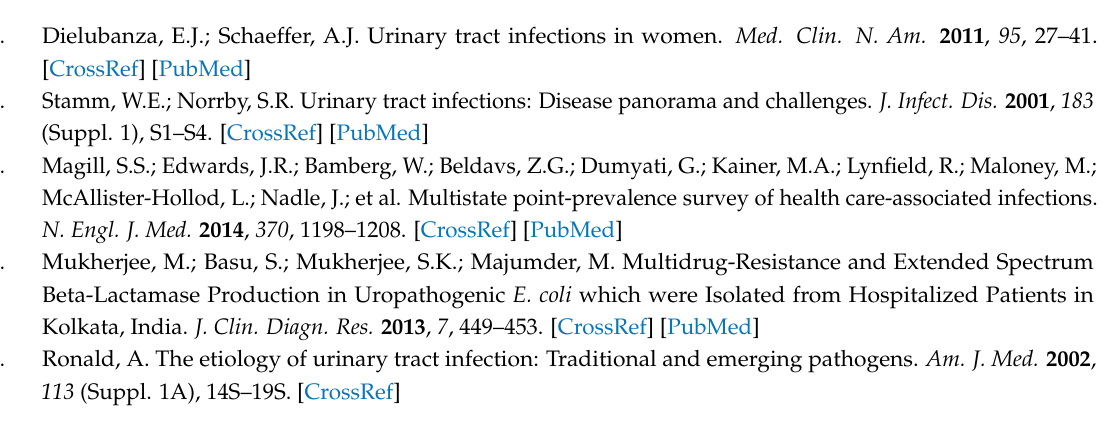
Table S1: Resistance profile of the set of clinical strains, Table S2: Standardization of the method